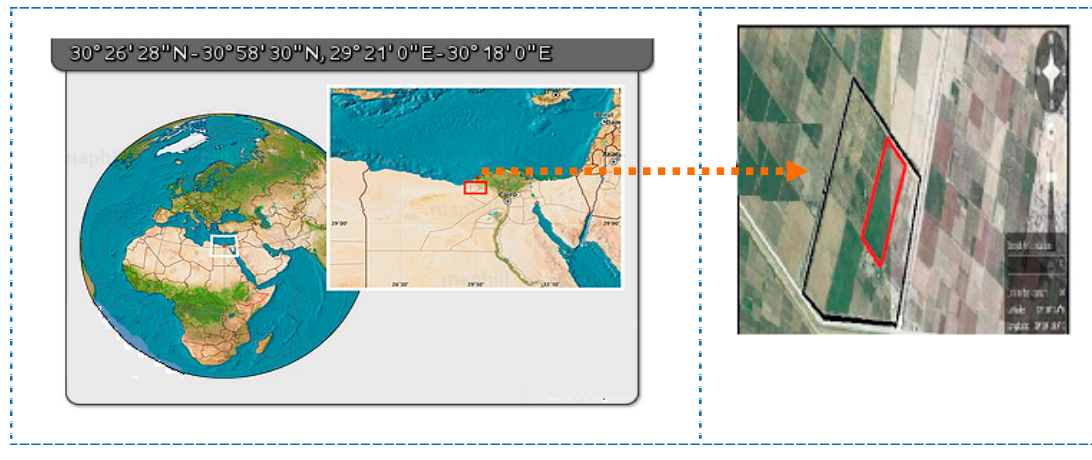
Figure 1. area of the experimental site. Figure 1. Area of the experimental